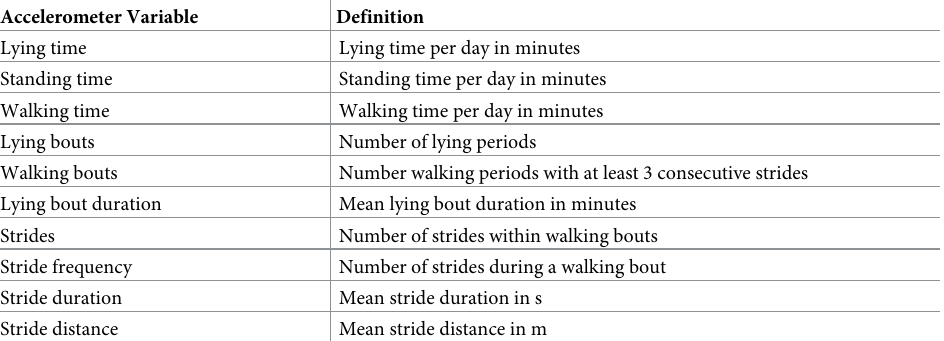
Table 1. Variables of RumiWatch 1 3D-accelerometers (RumiWatch, ITIN+HOCH GmbH, Fu¨tterungstechnik, Liestal, Switzerland) as described and validated by Alsaaod et al.